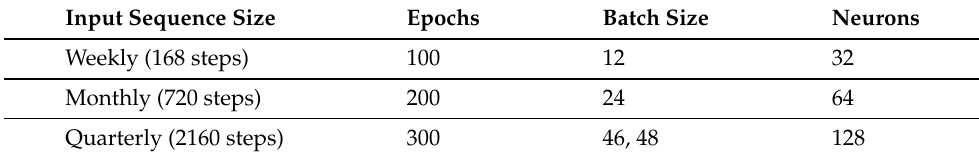
Table 1. Possible parameter configurations for iterative training of vanilla LSTM